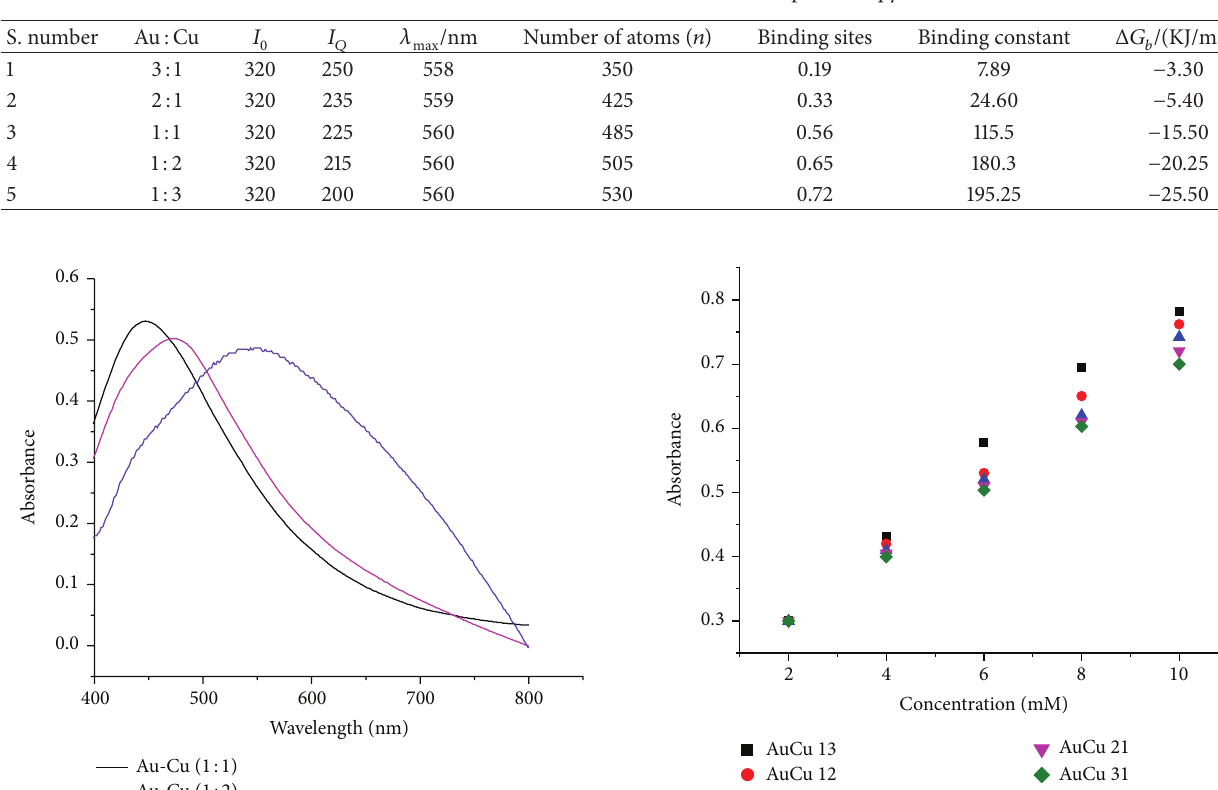
Table 4: Parameters obtained from fluorescence spectroscopy.